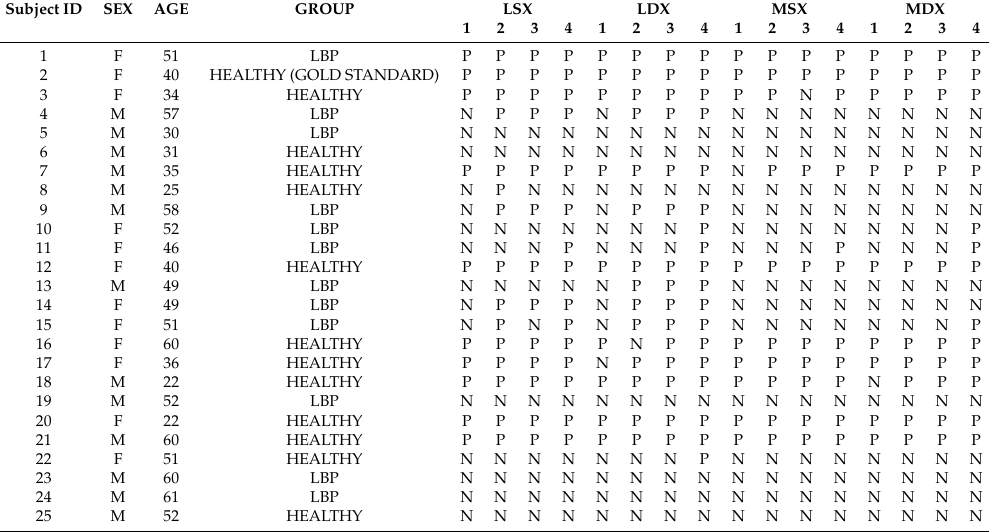
Table 2. Results of the proposed likelihood algorithm. The ID2 subject is the gold standard. P = positive, subject with FRP in the considered cycle of the corresponding channel. N = negative, subject without FRP in the considered cycle of the corresponding channel. LPB, lower back